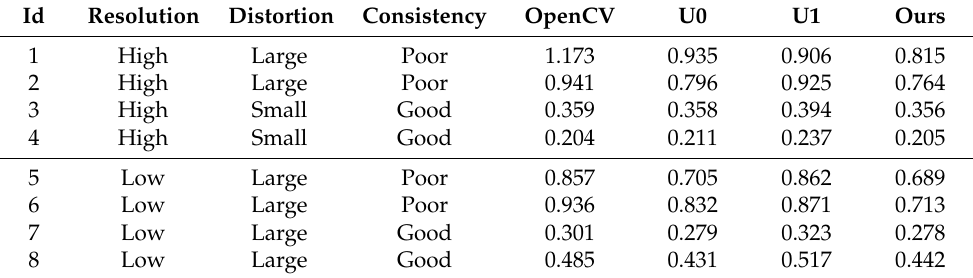
Table 1. Calibration accuracy.